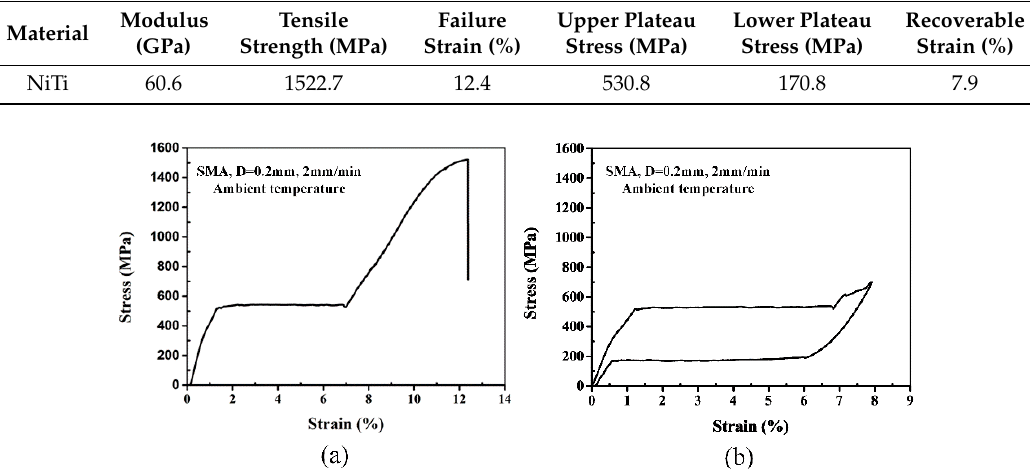
Table 1. The main mechanical characteristics of SMA wires [24].